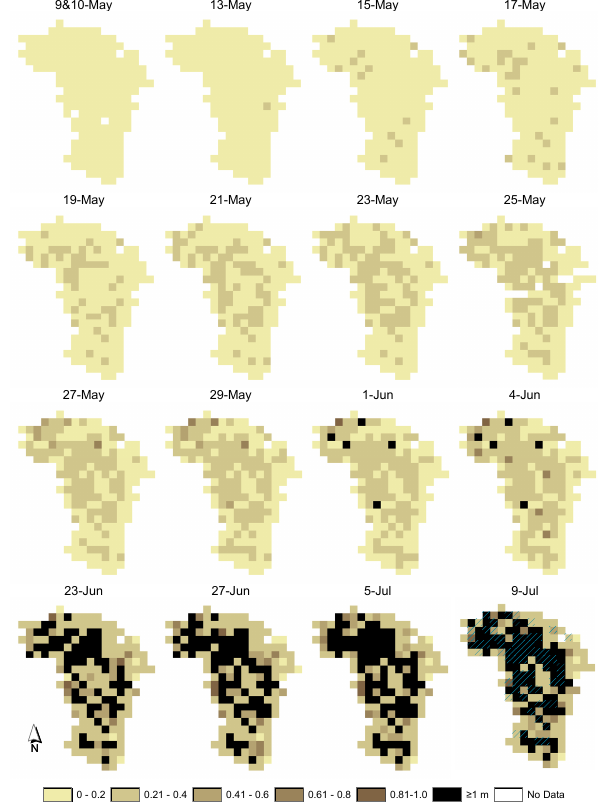
Fig. 6. Frost table depths at the peatland site. Area flooded in early- spring from 9 May to 13 May (hatched grids) overlays the frost table depths measured on 9 July. Any intersecting grids with flooding and ≥ 1m thaw indicate those flooded grids were at the same locations as the deepest thaw records. All values are in m and grid cells are mapped at a resolution of 8m by 8m from 8m by 4m survey